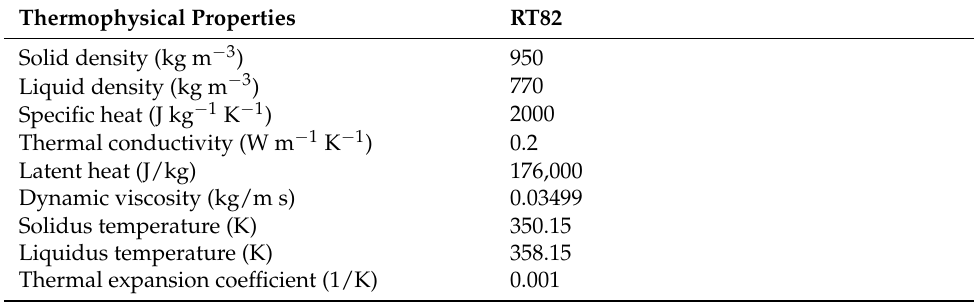
Table 1. Thermophysical properties of the phase change material RT82 [25].